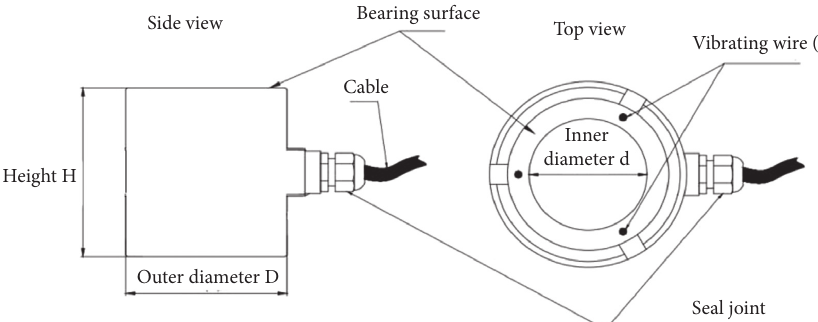
Figure 4: Structural diagram of a vibrating wire anchor cable meter.